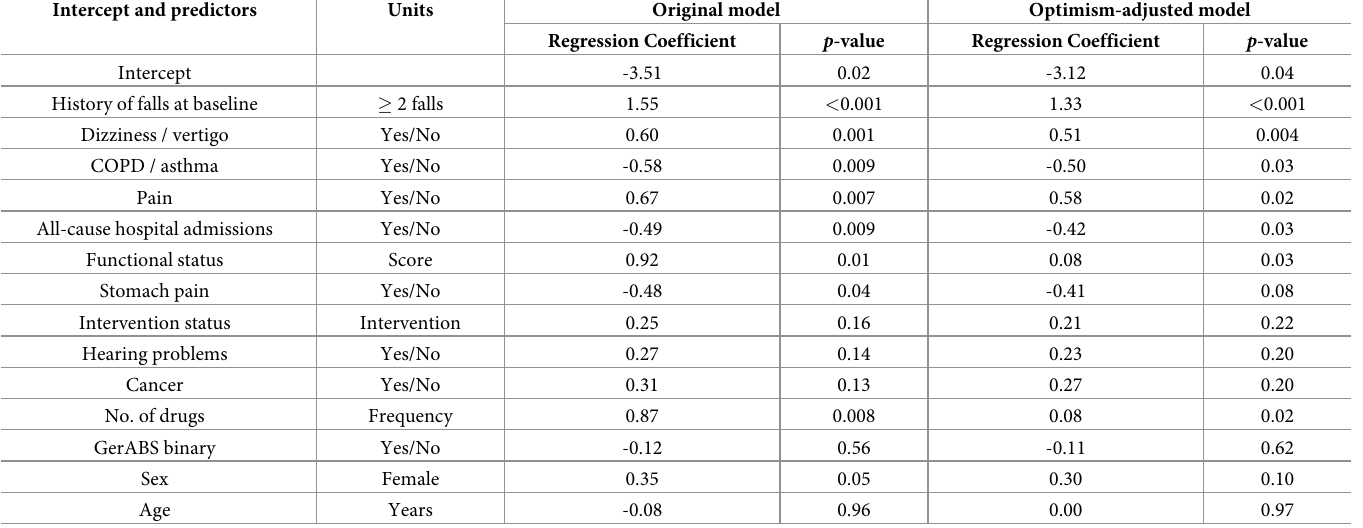
Table 3. Selected model for falls within 6-months of follow-up (developed and internally validated). Intercept and